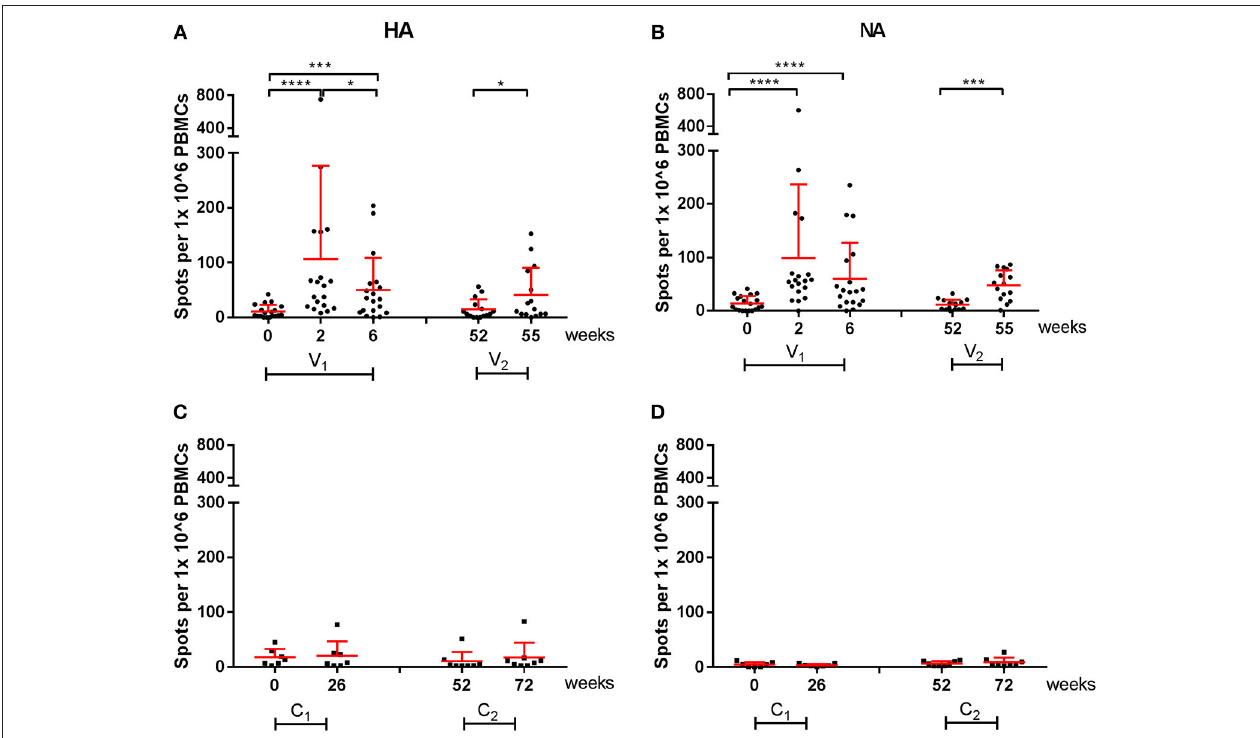
FIGURE 6 | A(H1N1)pdm09 virus-specific cellular responses in season 1 and 2. Responses against HA (A) and NA (B) peptide pools were measured with an IFN- γ ELISpot in individuals of the vaccine group. In addition, responses against HA (C) and NA (D) were measured on controls. In red the mean and SD of each data set is depicted. ELISpot data were analyzed with Wilcoxon matched-pairs rank test * P < 0.05, *** P < 0.001, **** P < 0.0001.